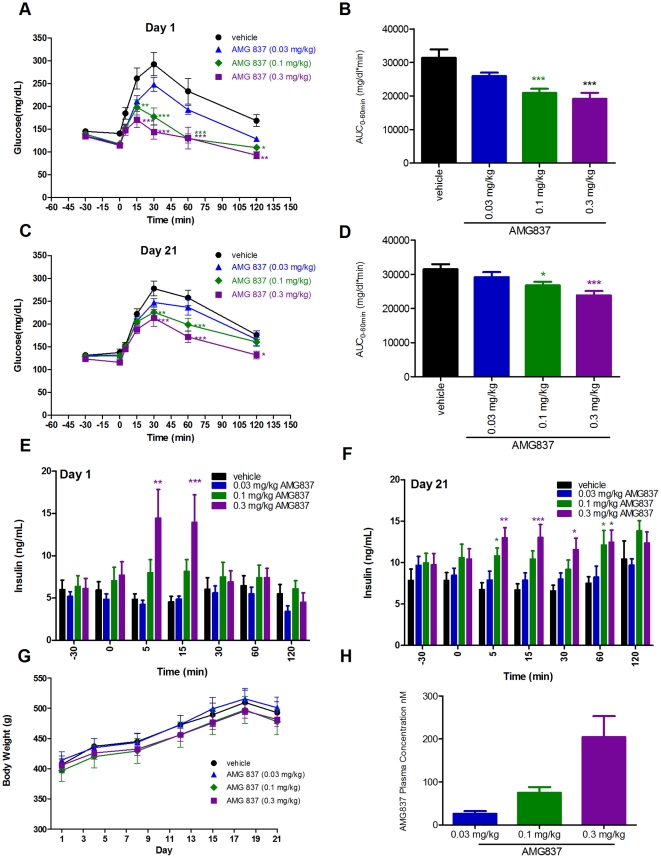
Efficacy of AMG 837 in Zucker fatty (fa/fa) rats following daily dosing for 21-days.8-week old Zucker fatty rats were administered a single bolus of AMG 837 (at 0.03, 0.1 and 0.3 mg/kg, n = 6/group) by oral gavage 30-minutes prior to an intraperitoneal glucose challenge at t = 0 minutes. (A) Blood glucose during the IPGTT (black circle = vehicle, blue triangle = 0.03 mg/kg AMG 837, green diamond = 0.1 mg/kg AMG 837 and purple square = 0.3 mg/kg AMG 837). (B) Glucose AUC (from −30 to 120 minutes) during the IPGTT. (E) Plasma insulin levels during the IPGTT (black bar = vehicle, blue bar = 0.03 mg/kg AMG 837, green bar = 0.1 mg/kg AMG 837 and purple bar = 0.3 mg/kg AMG 837). Once daily dosing was continued for 21-days. On day 21, an IPGTT was performed in an identical manner to that on day 1. (C) Blood glucose (D) glucose AUC (from −30 to 120 minutes) and (F) plasma insulin levels were measured from the day 21 IPGTT. Figure legends are identical to those of the day 1 figures. (G) Body weights of the animals were followed through the course of the 21-day study; no difference in BW was observed between the groups. (H) Total plasma concentration of AMG 837 30-minutes following the final dose on day 21. Statistical significance compared to vehicle treated animals is denoted by * (p<0.5), ** (p<0.01) and *** (p<0.001) as determined by one-way or two-way ANOVA.